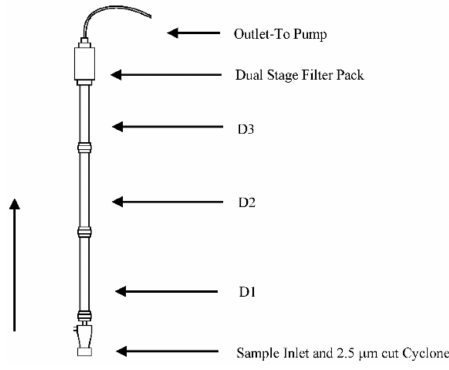
Figure 1. Three Annular Denuder System Set-Up (3-ADS), as prescribed by the United States Environmental Protection Agency (US EPA)